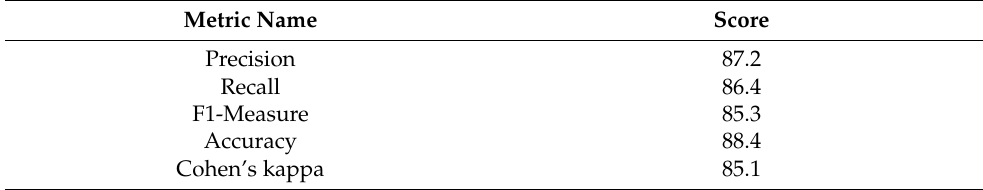
Table 15. Evaluation